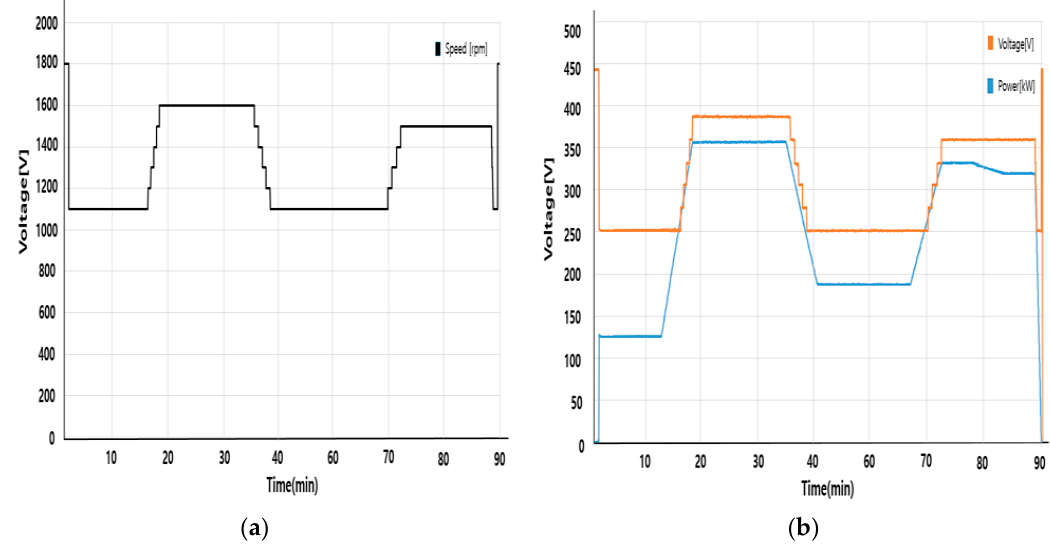
Figure 17. ( a ) The result of speed to load variation, ( b ) voltage according to load variation .